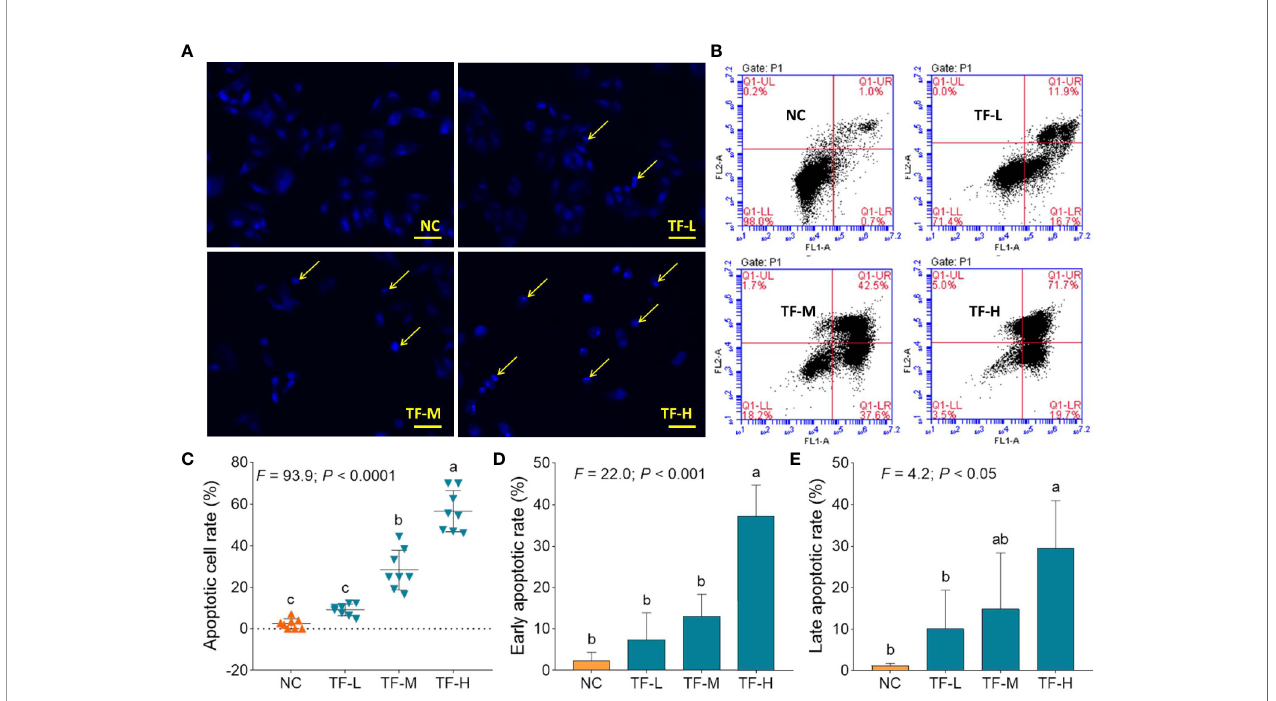
FIGURE 2 | DAPI staining observation (A) and fl ow cytometry analysis (B) on A375 cells with thea fl avin (TF) treatment. Statistical analysis of apoptotic cell rate (C) , statistical analysis of early apoptotic rate (D) and statistical analysis of late apoptotic rate (E) . By means of Fisher ’ s least signi fi cant difference (LSD) multiple comparisons, data (mean ± SD) with same lowercase letter (a vs. ab; ab vs. b; b vs. b; c vs. c) indicate no signi fi cant difference between each other, while data with different letters (a vs. b vs. c) indicate signi fi cant difference with each other. Scale bar = 100 m